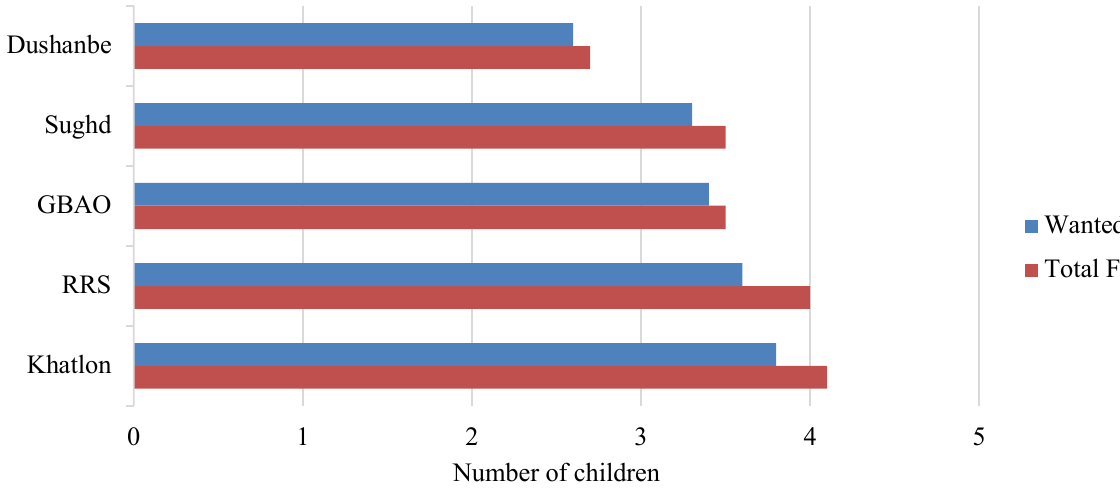
Figure 1. Wanted and total fertility rates, Tajikistan, 2017 Family